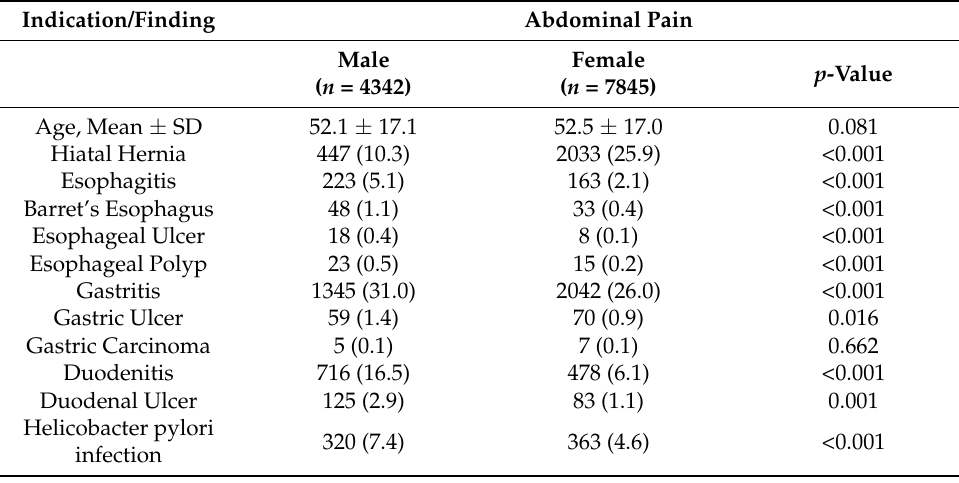
Table 3. Upper endoscopy findings for the indication of abdominal